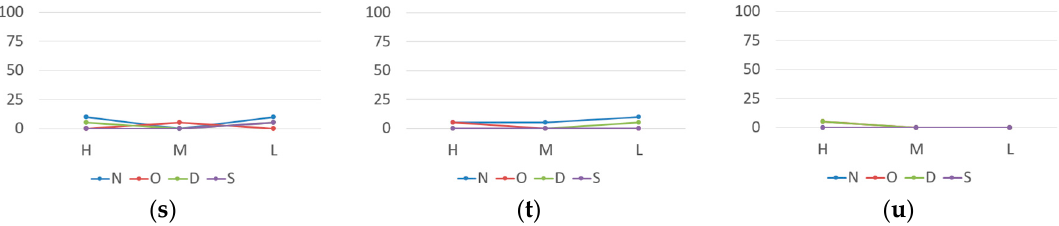
Figure 16. Artwork identification precision for the seven types of features for the three types of monitors. ( a ) 79-SIFT; ( b ) 32-SIFT; ( c ) 23-SIFT; ( d ) 79-SURF; ( e ) 32-SURF; ( f ) 23-SURF; ( g ) 79-FAST;